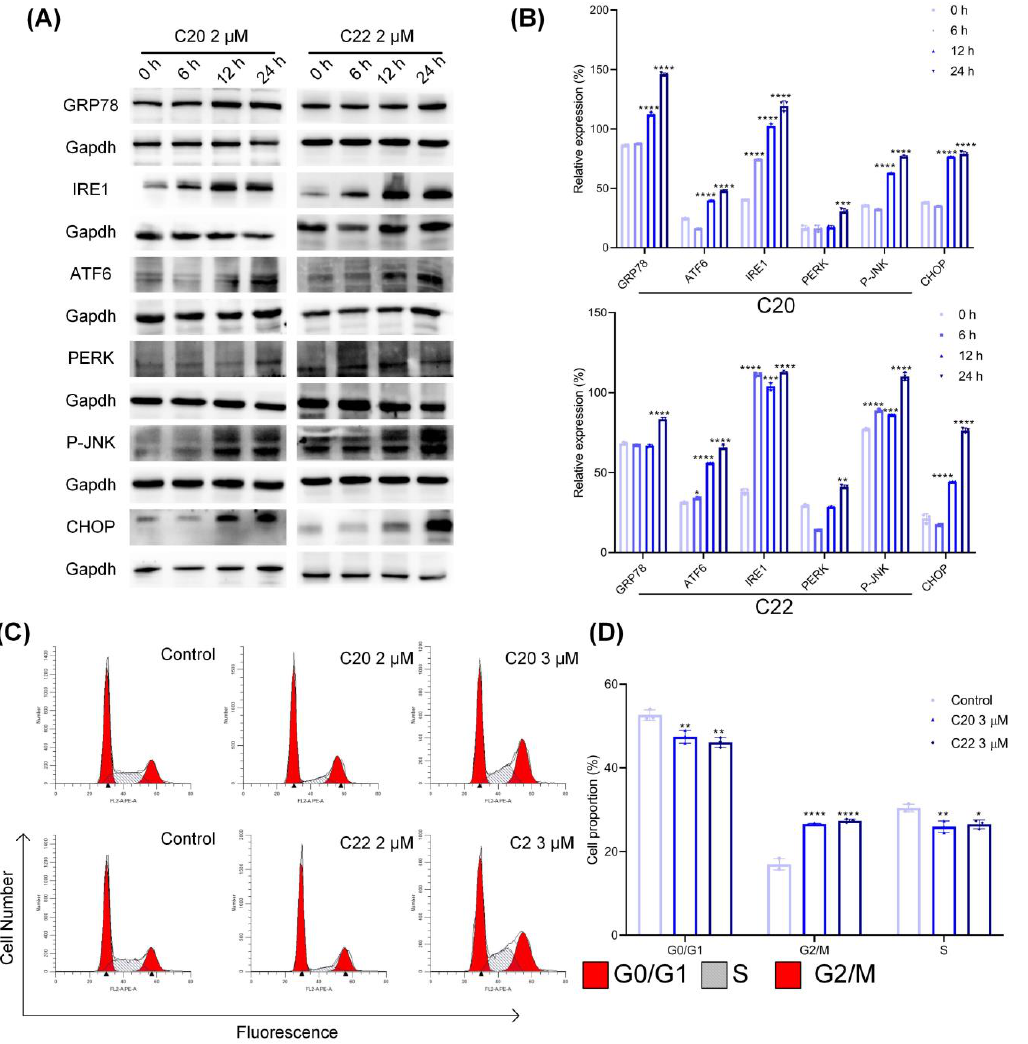
Figure 6. Treatment with C20/C22 induced ER stress and cell-cycle arrest of HepG2. ( A , B ) Expres- sions of ER stress-associated proteins in HepG2 cells after treatment with 2 µ M C20/C22 for 0, 6, 12, and 24 h. All proteins were normalized with the expression of Gapdh ( n = 3). ( C , D ) Cells were stained with PI after 24 h of C20/C22 incubation, and flow cytometry was used to determine the proportion of cells in each stage of the cell cycle ( n = 3). The reported data correspond to the mean ± SD of three independent experiments. The p -value was analyzed by one-way ANOVA followed by Tukey’s test using GraphPad Prism version 8.00. * p < 0.05, ** p < 0.01, *** p < 0.001, and **** p < 0.0001 vs. 0 h/control group.